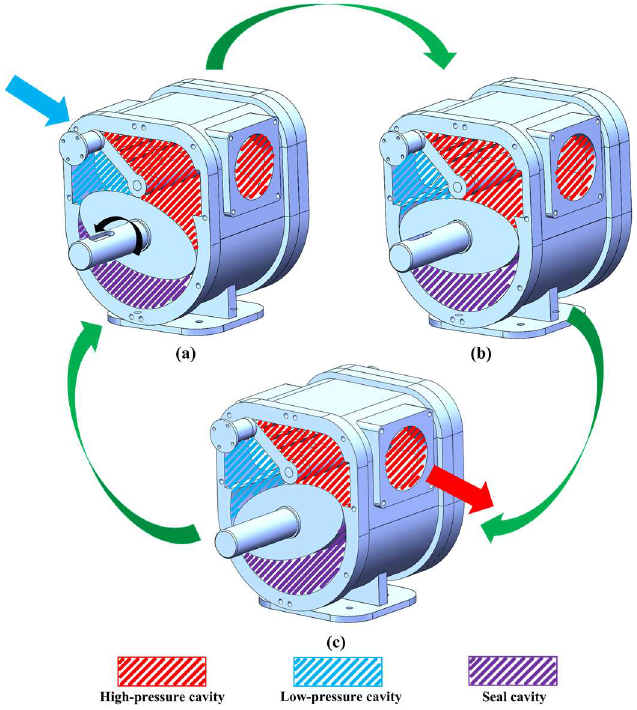
Figure 3. Working principle. ( a ) Admission state ( b ) Intermediate state ( c ) Exhaust state